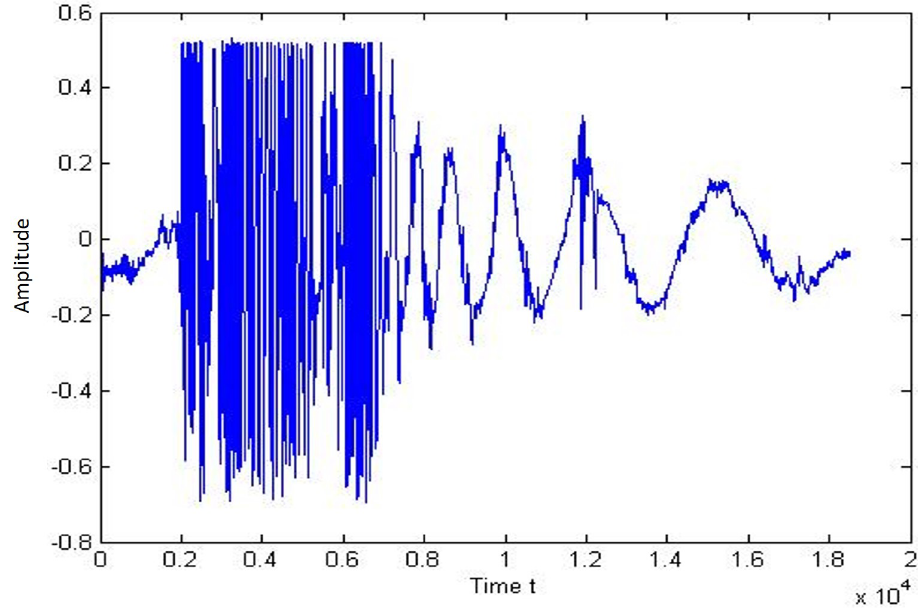
Figure 18. Plot of signal for running of single